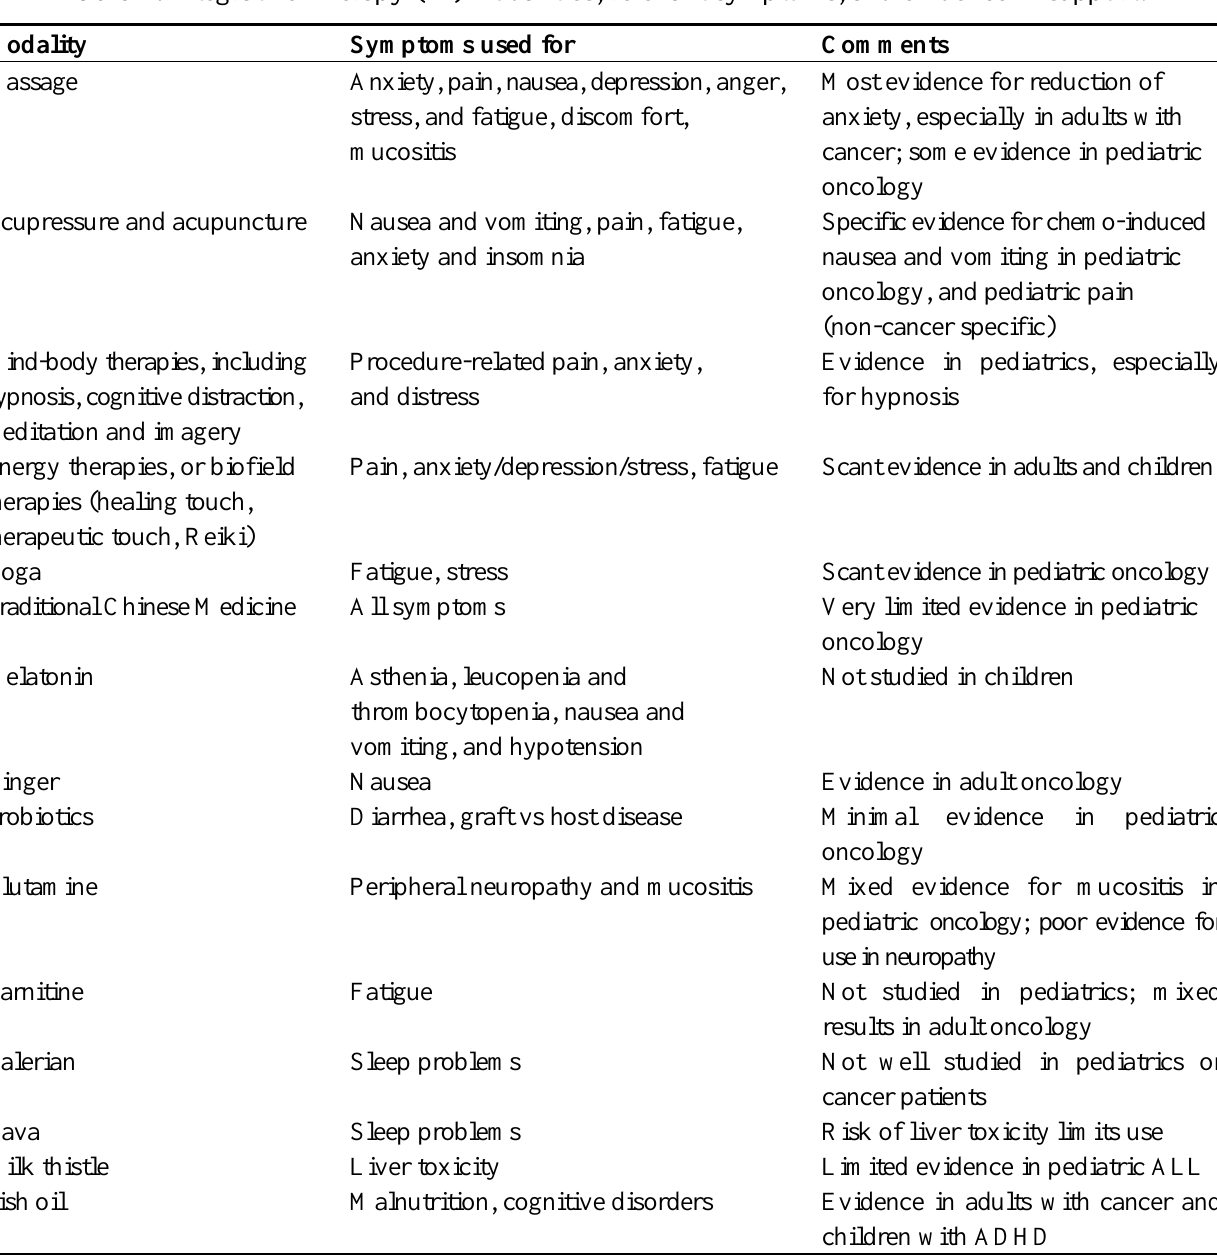
Table 1. Integrative Therapy (IT) modalities, relevant symptoms, and evidence in